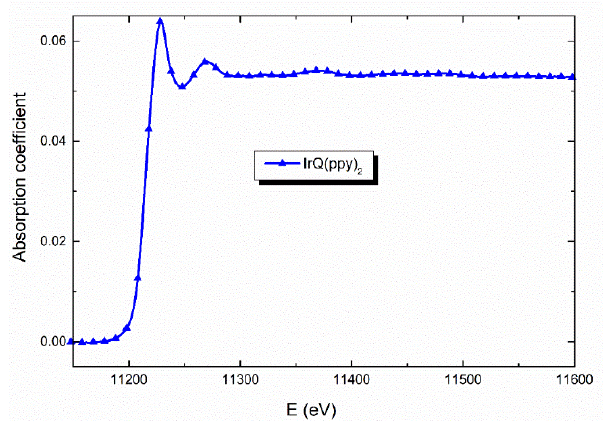
Figure 2. X-ray absorption spectra of the IrQ(ppy) 2 organometallic compounds.